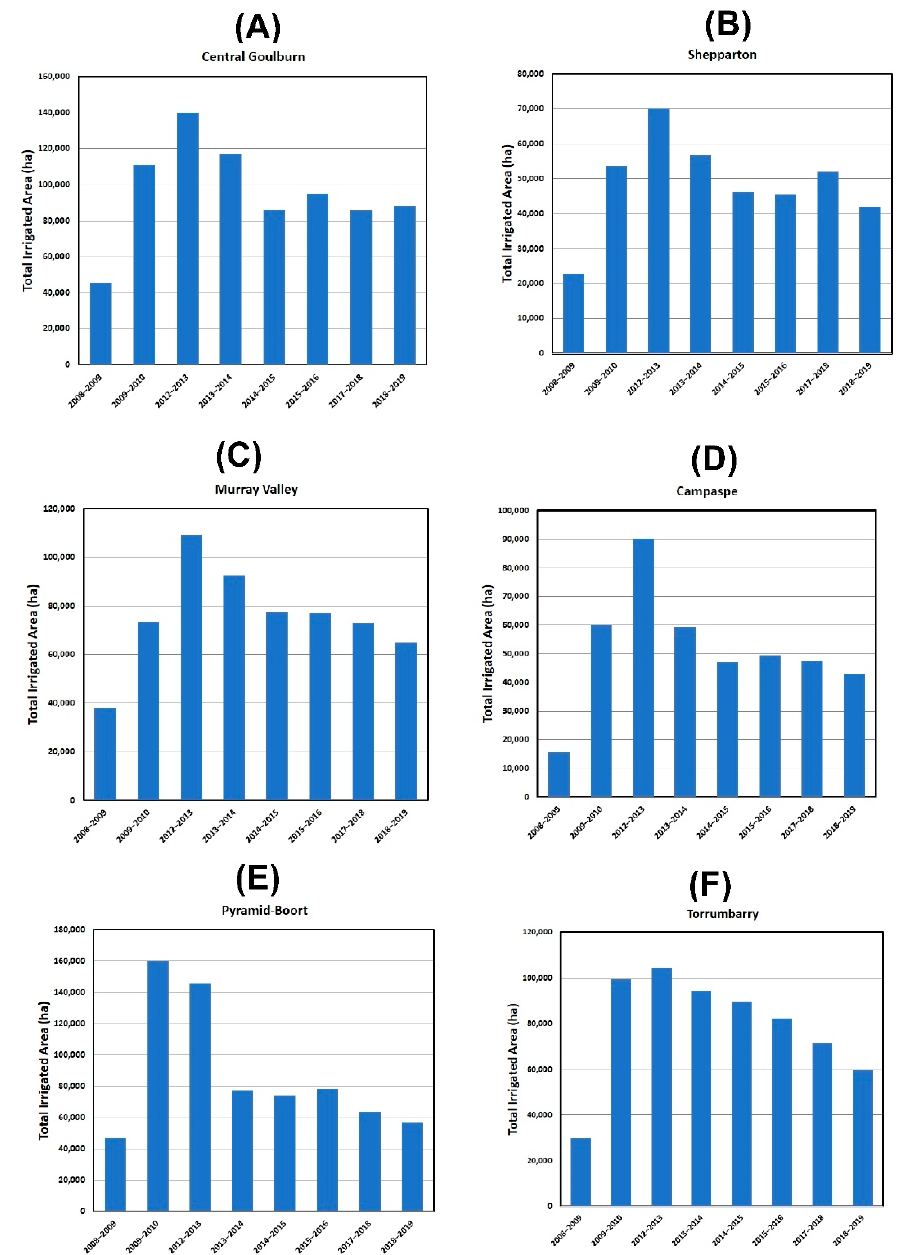
Figure 8. Changes in irrigated land cover of six irrigated sub-regions in North-Central Victoria during 2008–2009 and 2018–2019. ( A ) Central Goulburn; ( B ) Shepparton; ( C ) Murray Valley; ( D ) Campaspe; ( E ) Pyramid-Boort; and ( F ) Torrumbarry.